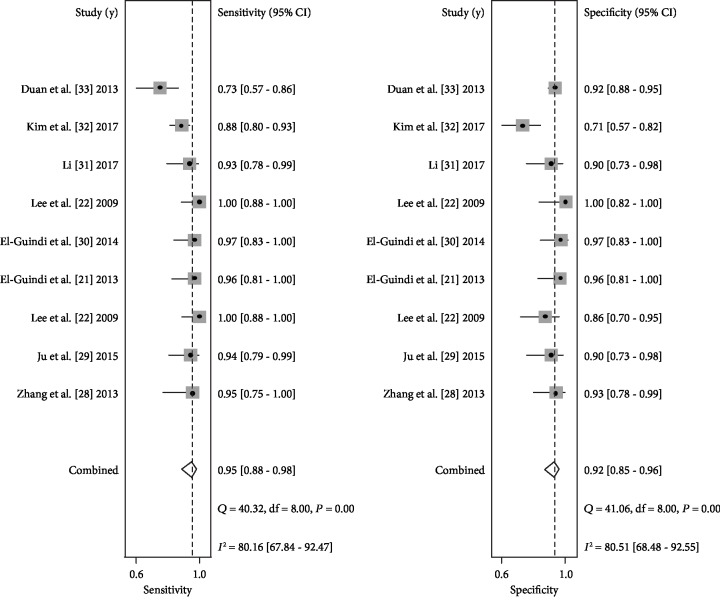
Forest plots of pooled sensitivity and specificity for HSF in the diagnosis of BA.